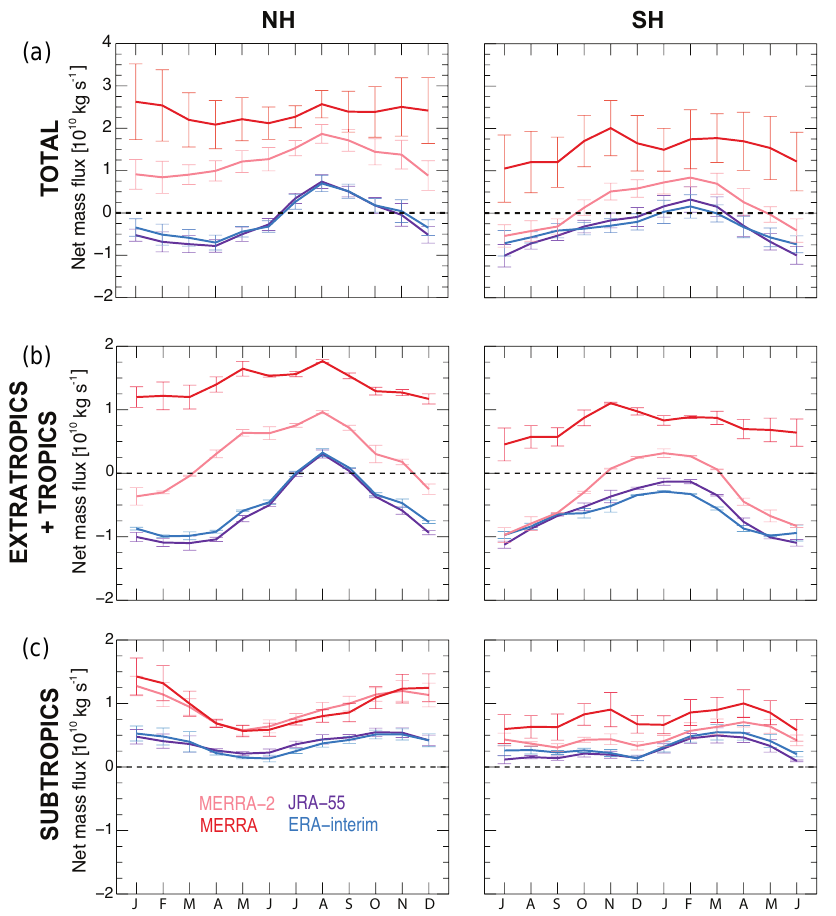
Figure 11. The same as in Fig. 9 but for non-normalized total net STE (top row), combined extratropical and tropical net STE (middle row), and subtropical net STE (bottom row).